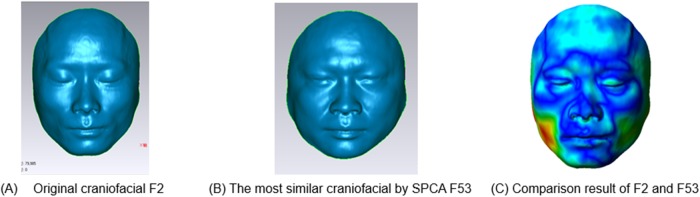
The comparison of similar and dissimilar regions.